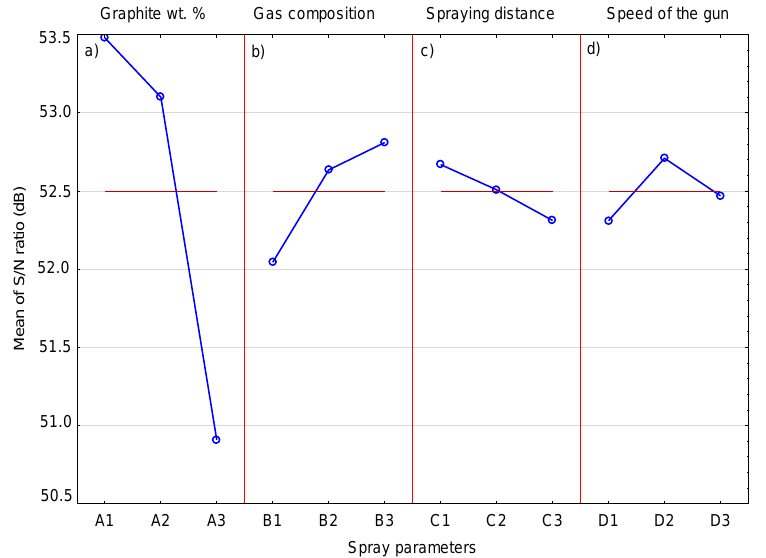
Figure 15. The mean S/N ratio for hardness.